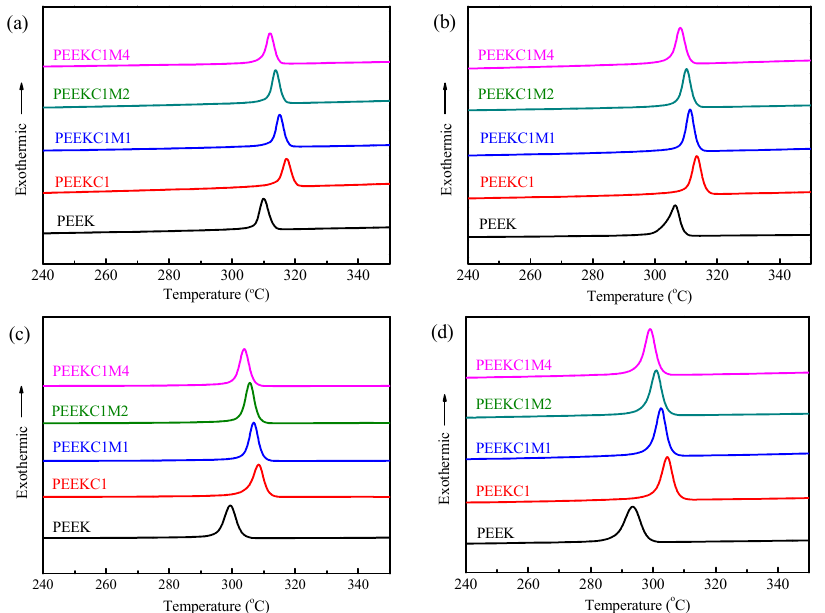
Figure 9. DSC traces of PEEK nanocomposites recorded during cooling process at ( a ) 2.5 °C/min, ( b ) 5 °C/min, ( c ) 10 °C/min, and ( d ) 20 °C/min after eliminating previous thermal histories.